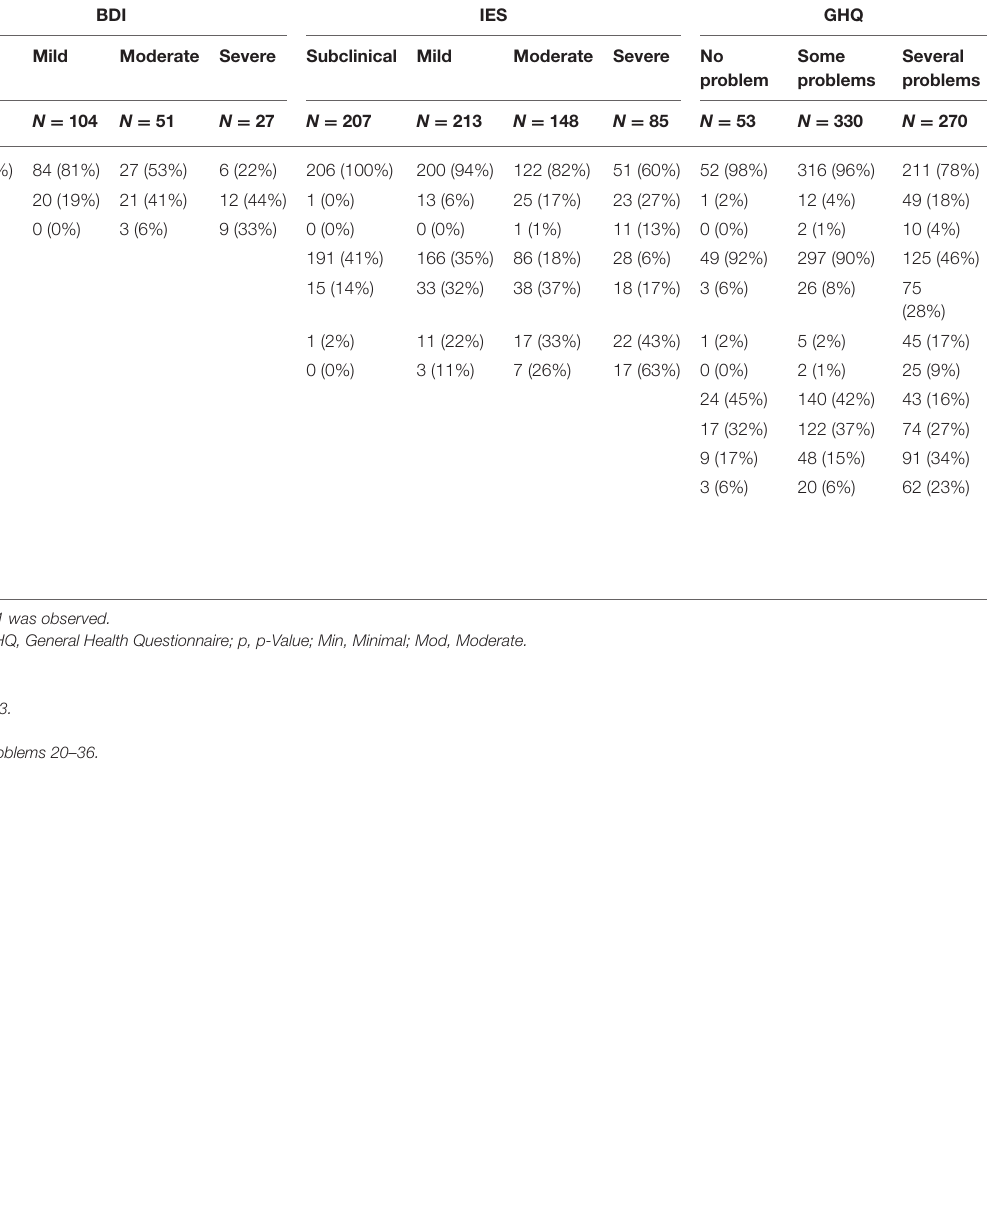
TABLE 5 | Focus on Anxiety, Depression, Stress, and Mental Health: analysis of categorical tests (IES, GHQ) data ( n , % column). Variable BAI BDI IES GHQ Minimum Medium High Minimal Mild Moderate